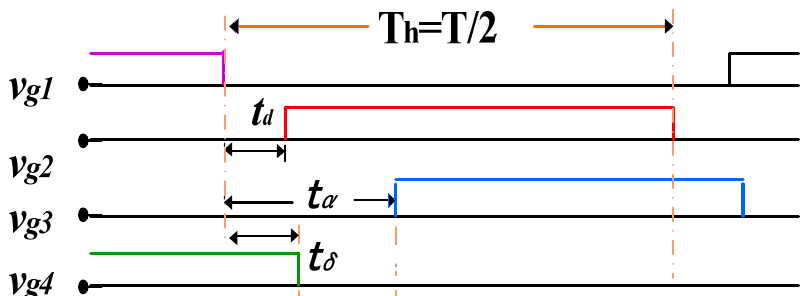
Figure 3. Gate voltage pulse sequences.